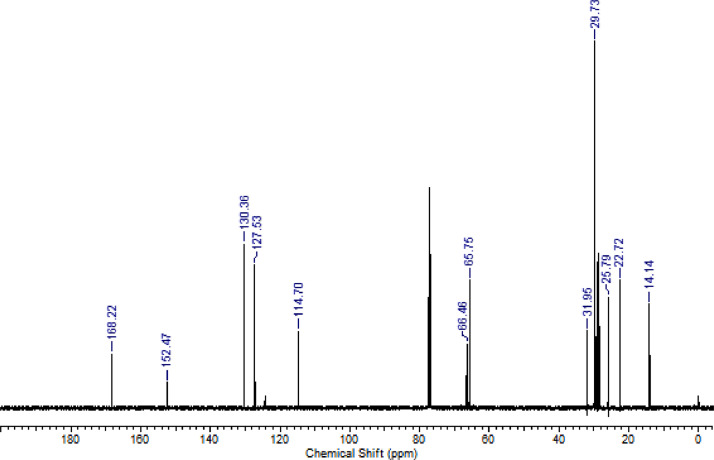
13C NMR (CDCl3, 100 MHz) spectrum of compound 8b.